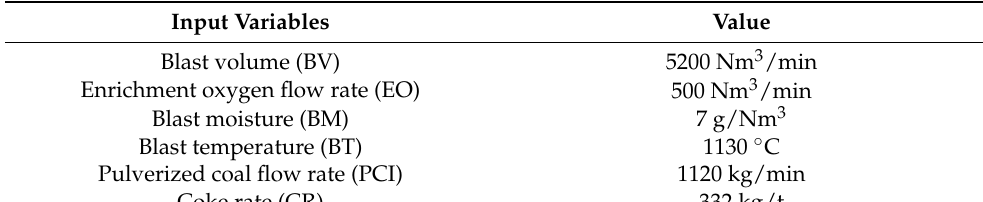
Table 3. Standard operation condition used in control simulation.